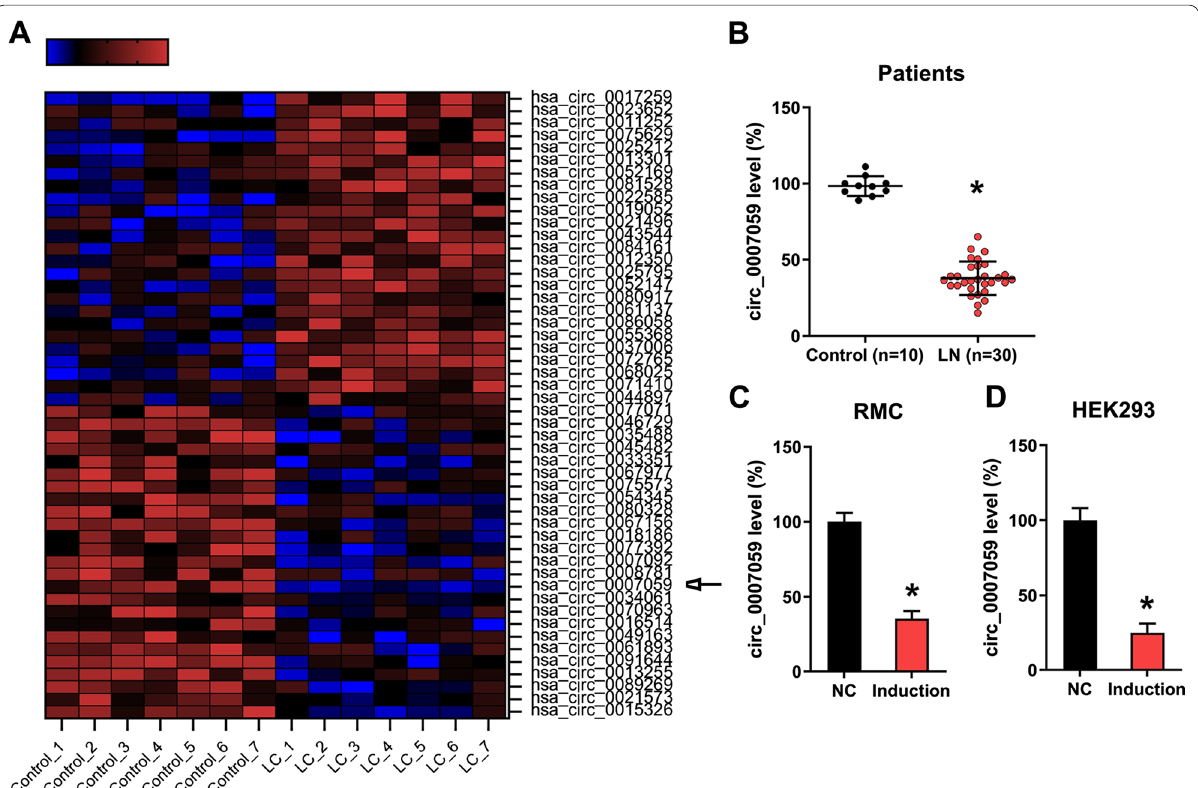
Fig. 1 Expression of circ_0007059 in kidneys, IFN‑induced RMCs and HEK293 cells, and patients with lupus nephritis (LN). A microarray analysis revealed differentially expressed genes between kidney samples from patients with LN (n 7) and normal healthy tissue (n 7) (biological = = replicates, 7; technical replicates, 1; repeat time, 3). B the expression of circ_0007059 in renal biopsy samples from patients with LN (n 30) and = surrounding normal tissue samples (n 10) by RT‑qPCR (biological replicates, as indicated; technical replicates, 3; repeat time, 3). C , D treatment of = RMCs and HEK293 cells with IFN (1,000 units/mL) for 24 h. RT‑qPCR was used to measure the expression of circ_0007059 (biological replicates, 3;